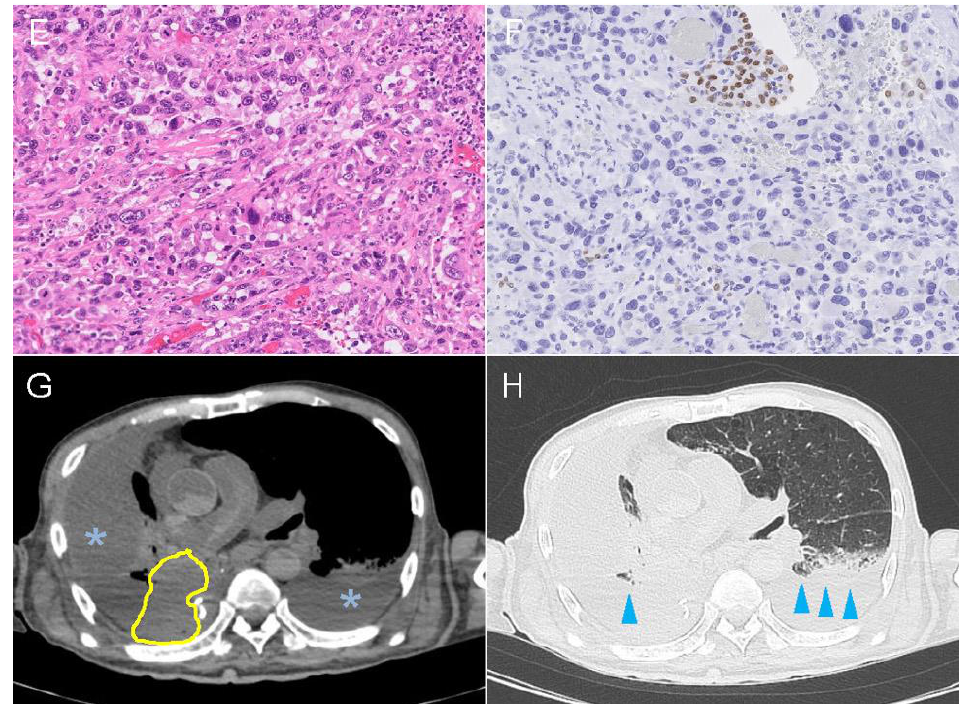
Figure 2. Imaging and microscopic findings in case 2. Computed tomography scan of the chest showing tumor (yellow outline) before ICI treatment on mediastinal ( A ) and lung ( B ) window images. PET-CT scan found high FDG uptake in the mass located in right hilar region ( C , white arrowhead) and in the liver ( D , white arrow). Routine hematoxylin & eosin staining revealed pleomorphic carcinoma with giant and spindle cells, 200 × ( E ). Immunostaining with TTF-1 demonstrated loss of expression in the most carcinoma cells and residual expression in the entrapped bronchial and alveolar epithelium, 200 × ( F ). Postmortem chest scan showed increased amount of pleural e ff usion (asterisk) and bilateral consolidation (blue arrowhead) on mediastinal ( G ) and lung ( H ) window images.